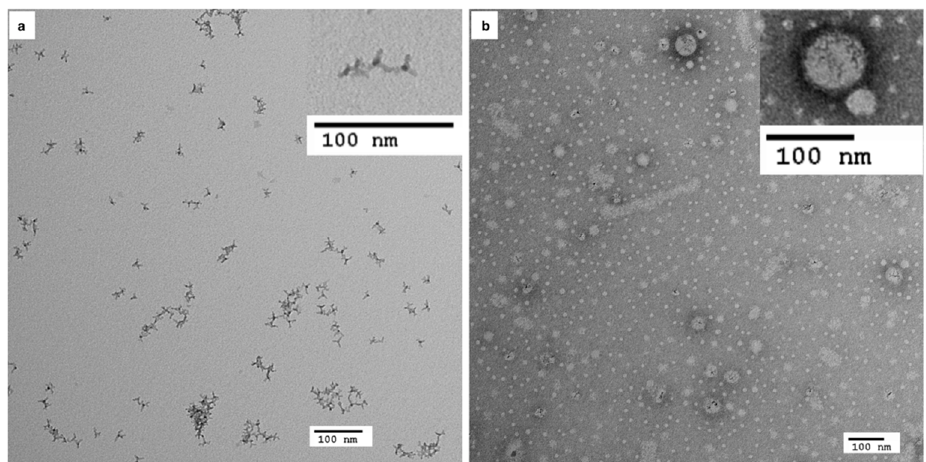
Figure 1. Transmission electron microscopy (TEM) images of ( a ) MPA-coated and ( b ) micelle encapsulated Mn-doped ZnSe tetrapod QDs.